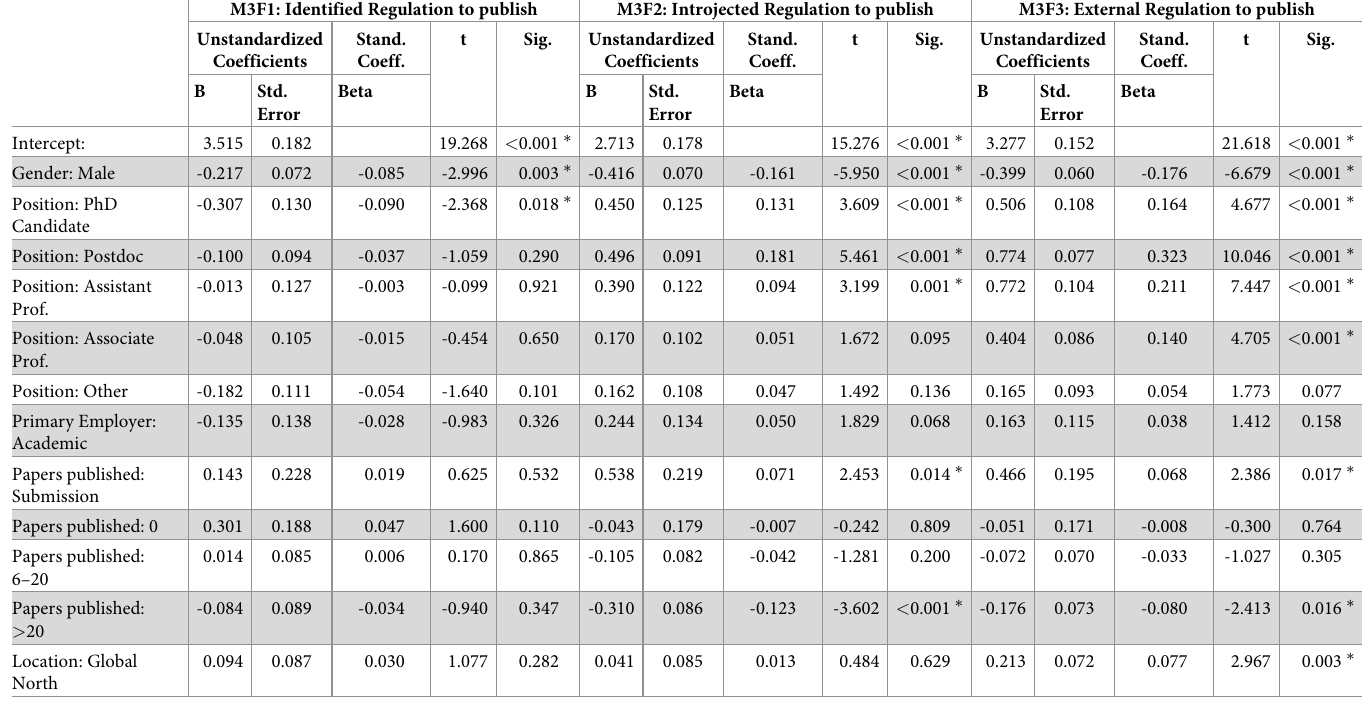
Table 3. Regression models of DV = M3F1 (N = 1305), M3F2 (N = 1294) & M3F3 (N = 1265); regressed onto the control